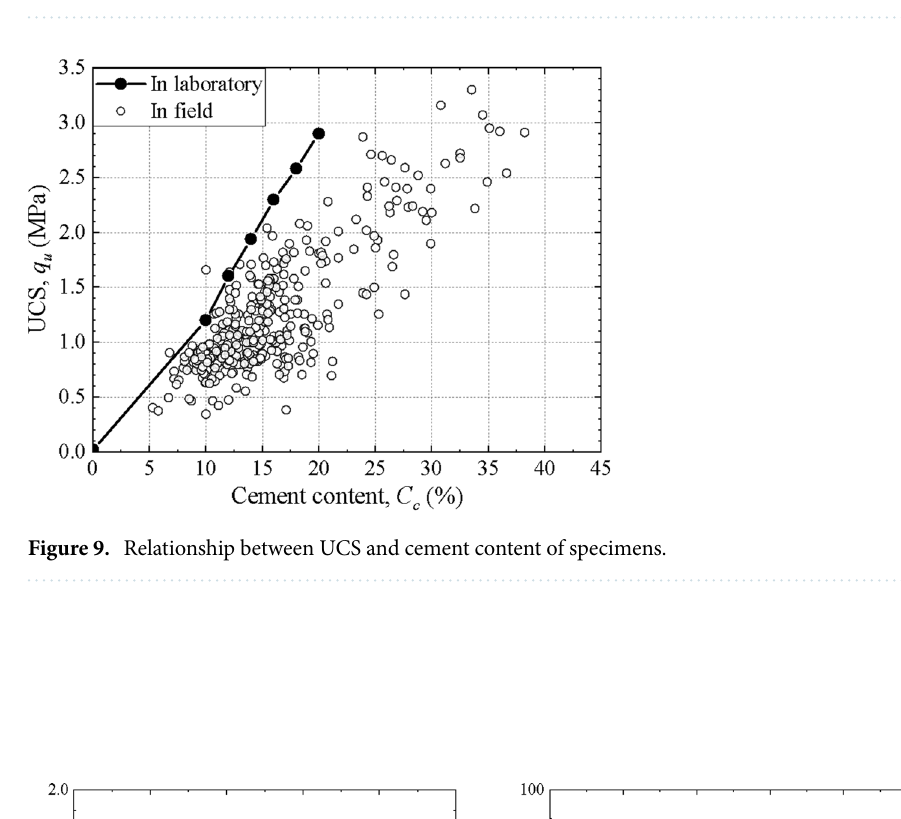
Figure 8. Distribution of the cement content and UCS with depth of typical columns.